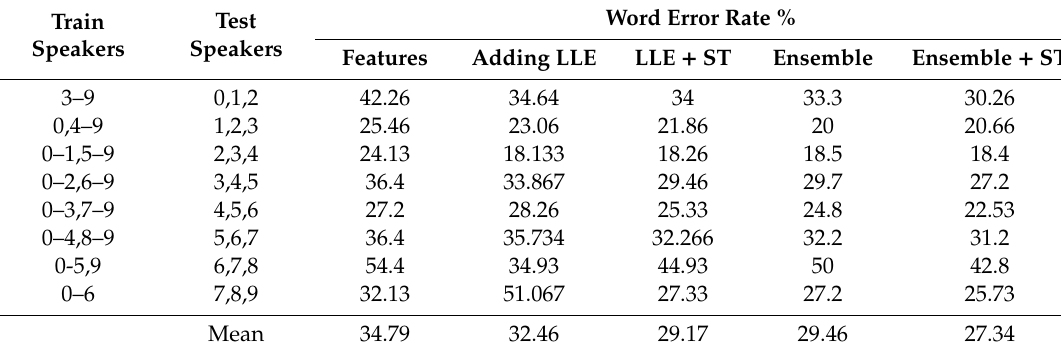
Table 7. Word Error Rate for 30% data as test.